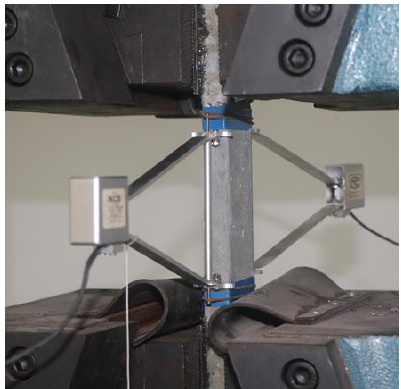
Figure 3: The thin Plate Specimen for uniaxial compression experiment.